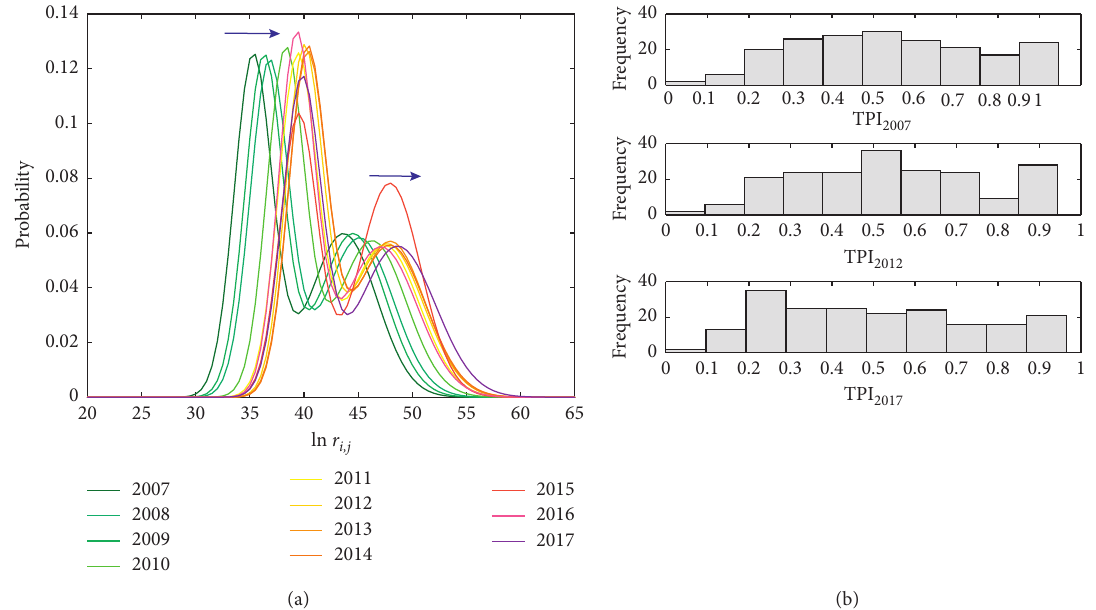
Figure 2: Evolution of trade resistance during the period 2007–2017: (a) distribution of trade resistance ln r purity indicator (TPI) in 2007, 2012, and